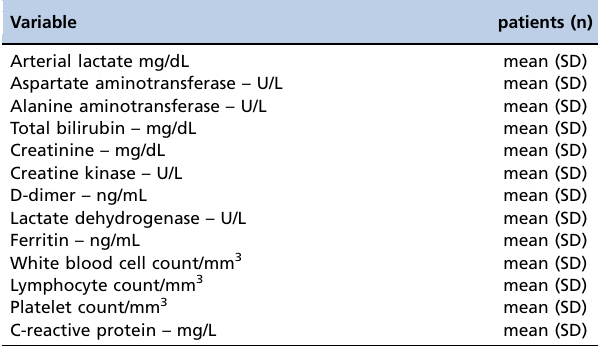
Table 2 - Laboratory findings at ICU admission.